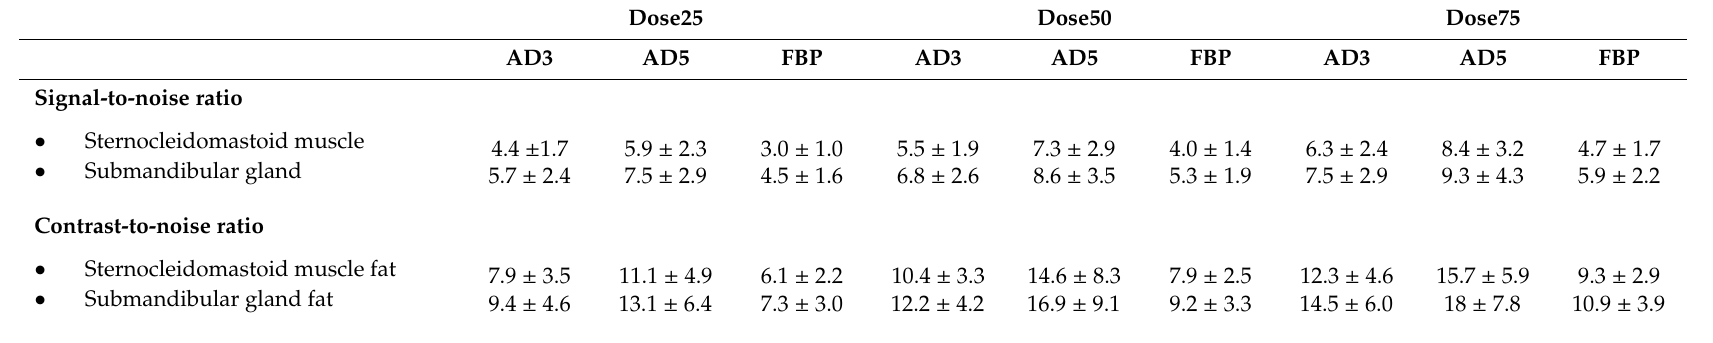
Table 2. Signal-to-noise ratio (SNR) and contrast-to-noise ratio (CNR)